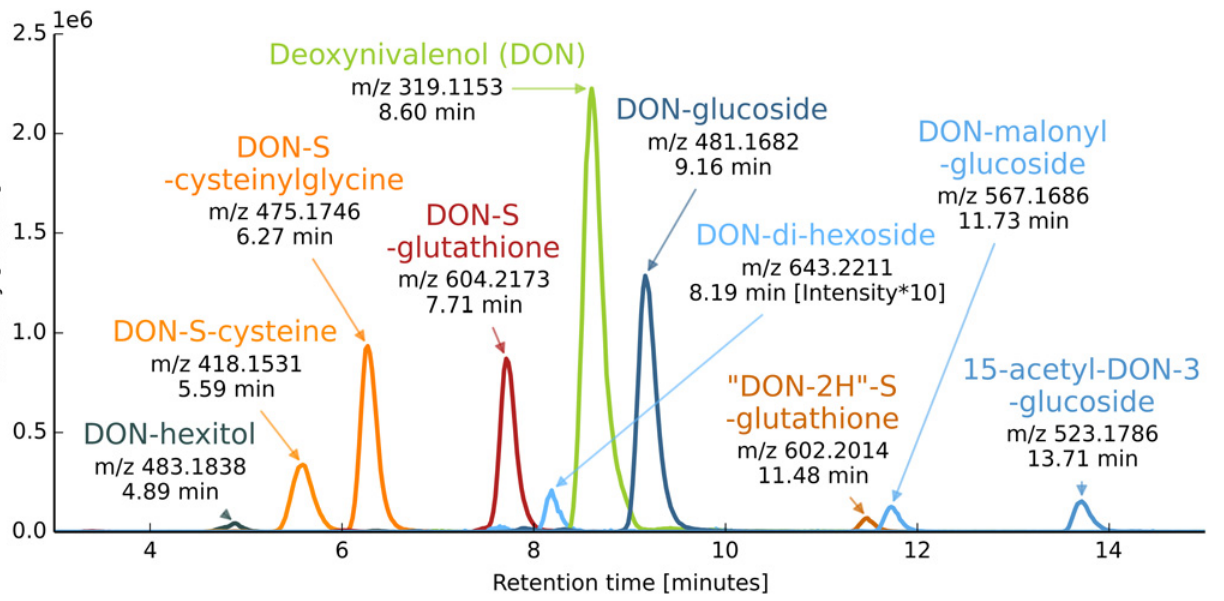
m/z values and LC-HRMS/MS spectra (marked with ‘ (cid:1) ’ in Table 1). Evaluation of the isotopic fine structure revealed the presence of sulfur in four of the nine DON biotransformation products. Three sulfur containing metabolites, namely DON-glutathione (GSH), DON-S-cysteinyl- glycine and DON-S-cysteine had already been putatively identified [24]. Herein, we putatively describe the characterization of the remaining DON biotransformation products. Based on